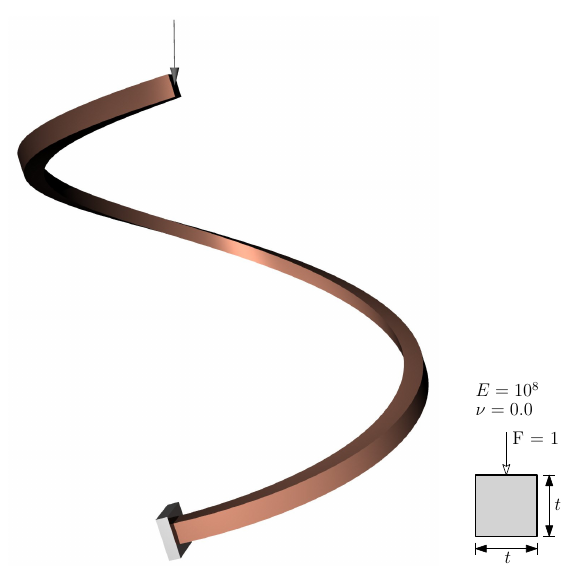
Figure 4. Helicoidal spring cantilever subjected to the unit force tip load and its cross-section.